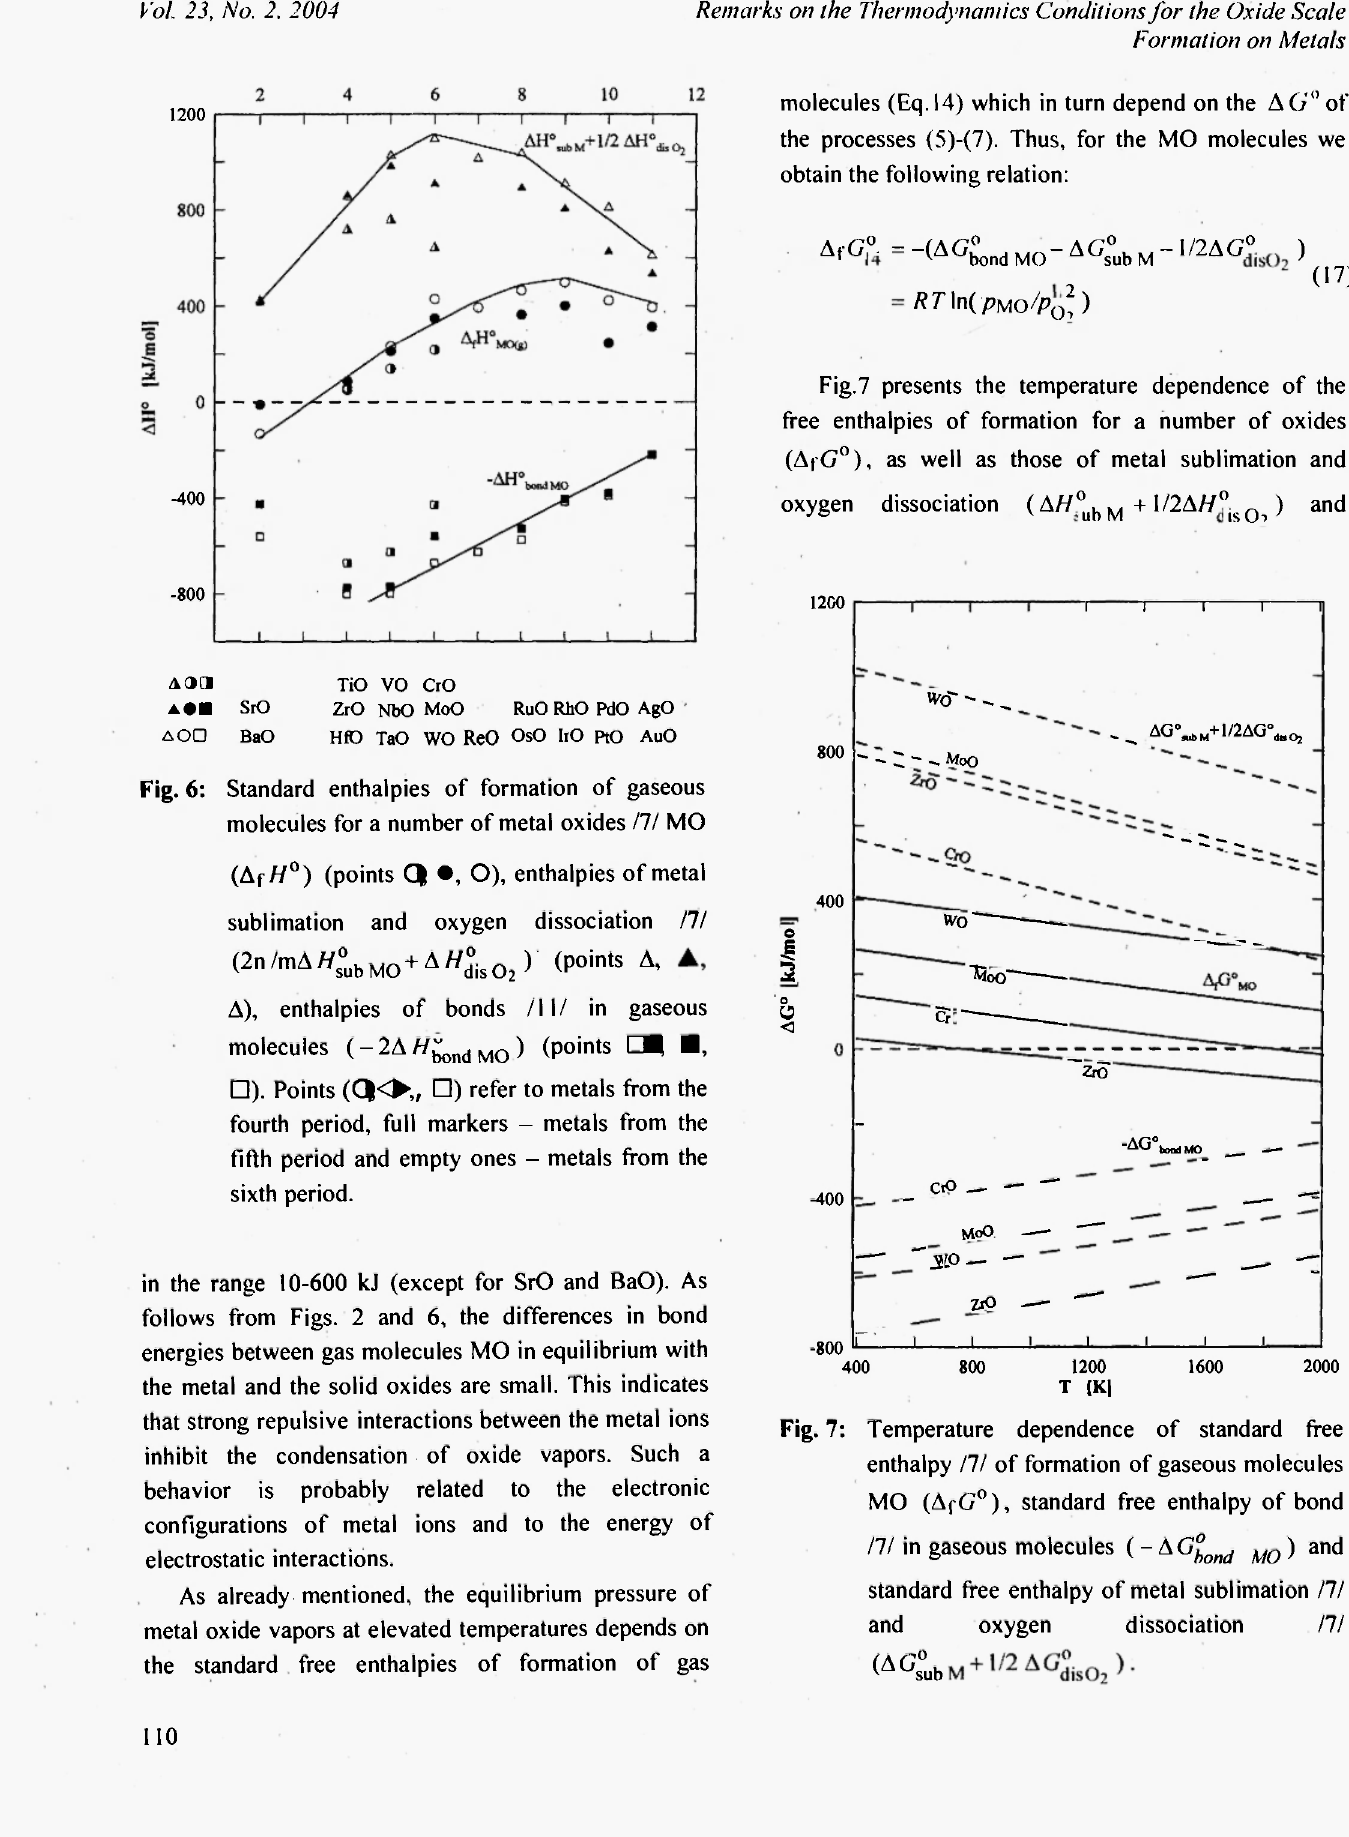
Fig. 7: Temperature dependence of standard free enthalpy 111 of formation of gaseous molecules MO (AfG°), standard free enthalpy of bond 111 in gaseous molecules (- A G° bond M O ) and standard free enthalpy of metal sublimation 111 and oxygen